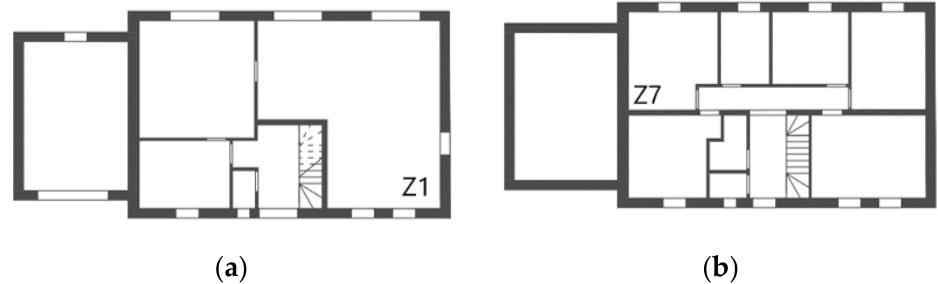
Figure 2. Plans of the house with indication of the considered thermal zones (Z1: living room, Z7: main bedroom). ( a ) Floor plan. ( b ) First floor.